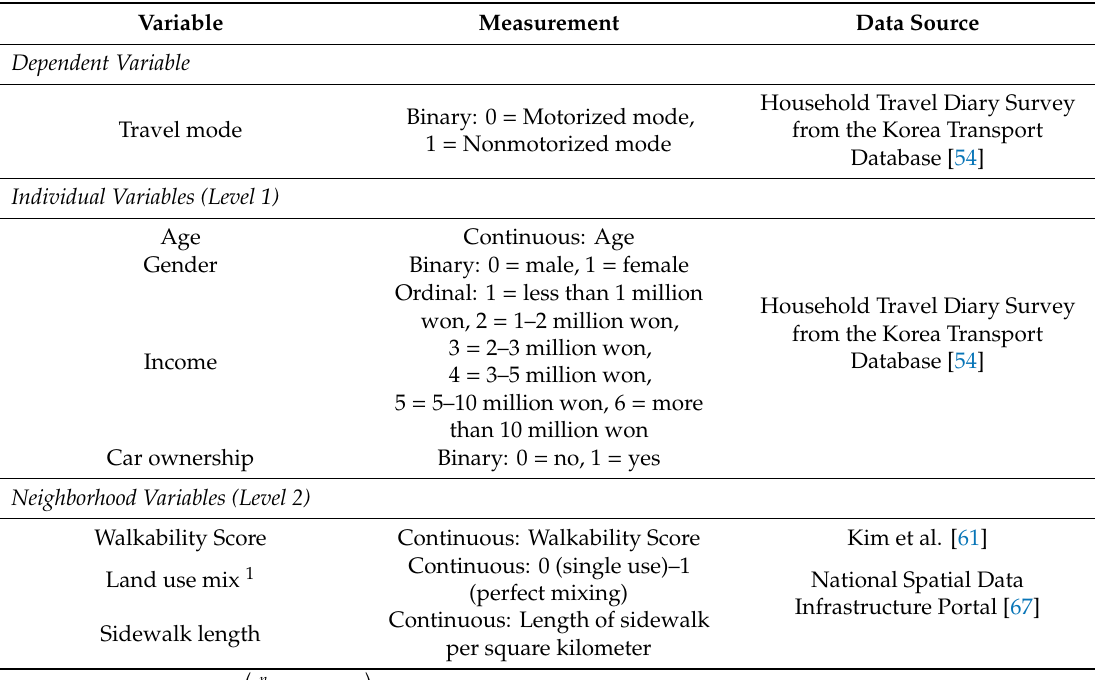
Table 1. Measurement, data source, and descriptive statistics of